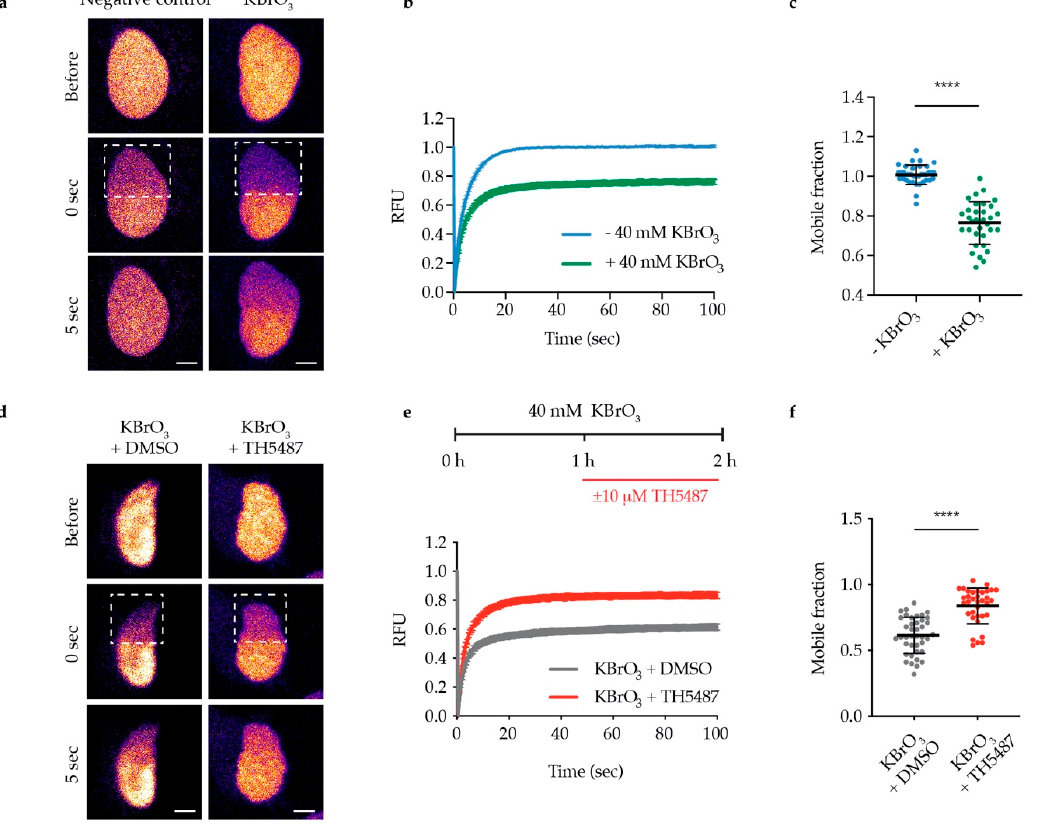
Figure 2. TH5487 alters OGG1–chromatin dynamics. ( a ) Representative false color images of nontreated and KBrO 3 -treated U2OS cells expressing OGG1-GFP are shown. Dashed outlines indicate bleached areas. Scale bar: 5 μ m. ( b ) Quantification of fluorescence recovery after photobleaching (FRAP). U2OS cells expressing OGG1-GFP were treated or not with 40 mM KBrO 3 for 1 h, a nuclear region was bleached, and recovery of fluorescence after photobleaching was recorded. RFU (relative fluorescence units). ( c ) Quantification of OGG1’s mobile fraction. Exposure to 40 mM KBrO 3 for 1 h reduced the nuclear mobility of OGG1-GFP. ( d ) Representative false color images of DMSO-treated and TH5487-treated U2OS cells expressing OGG1-GFP are shown. Dashed outlines indicate bleached areas. Scale bar: 5 μ m. ( e ) Quantification of FRAP experiments where U2OS cells expressing OGG1-GFP were treated with 40 mM KBrO 3 for 1 h, followed by another hour of additional exposure to 10 μ M TH5487 or 0.1% DMSO. ( f ) Quantification of OGG1’s mobile fraction. Treatment with TH5487 resulted in higher nuclear mobility of OGG1-GFP. Data are means ± SEM (b,e) or means ± SD (c,f) of three independent experiments. At least 35 cells from three independent experiments were quantified. Statistical significance was determined using unpaired two-sided t -tests (**** P < 0.0001).